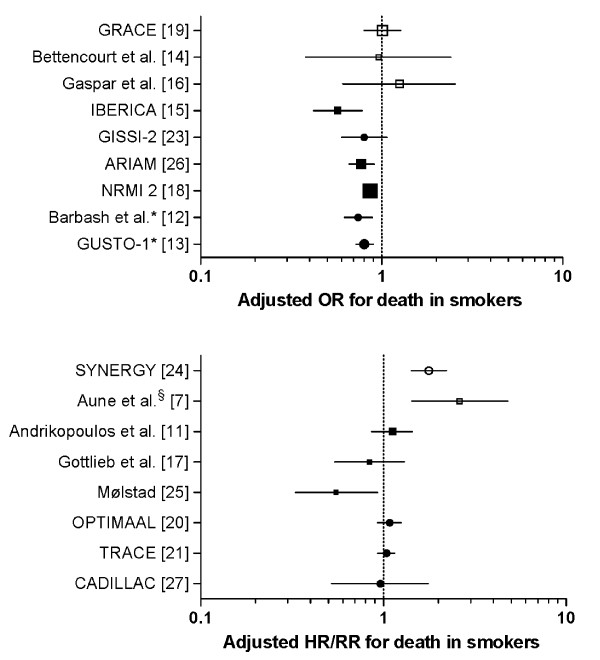
Forest plots of adjusted mortality in smokers vs. non-smokers. Odds ratios (OR)/hazard ratios (HR) with 95% confidence intervals for death during follow-up for smokers compared with non-smokers in the studies included. Circles indicate data derived from randomised trials. Squares indicate data derived from observational studies or registries. Open symbols indicate contemporary studies enrolling patients mainly after 2000. Closed symbols indicate older studies enrolling patients in the pre-thrombolytic and thrombolytic era. Symbol size reflects the sample size of the studies and registries. *Inverted OR from original paper. §The adjusted HR is for the conservative treatment cohort (2003) only. For the invasive cohort (2006) there was no difference in mortality for smokers and non-smokers (data not published).